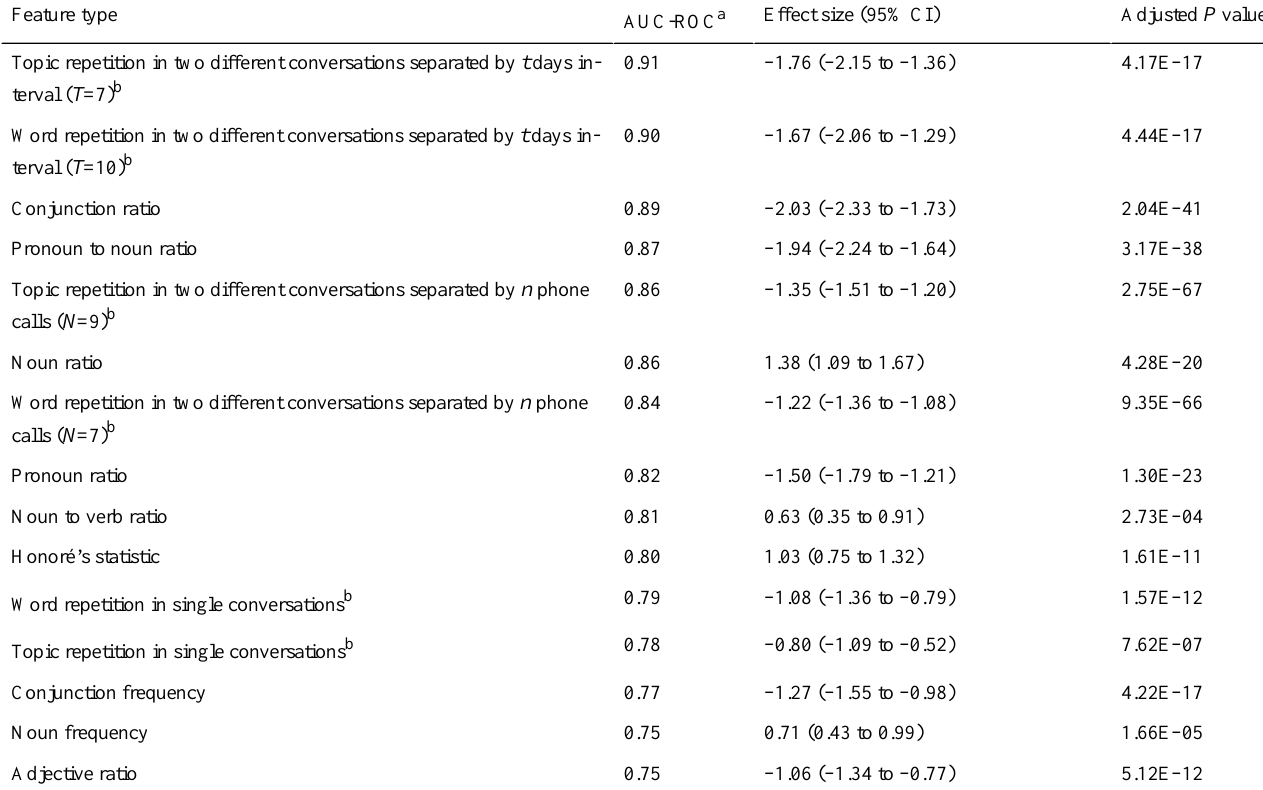
Table 2. Top 15 features of high discriminative power among linguistic features used in previous studies and repetition features. The table contains area under the receiver operating characteristic curve (AUC-ROC) score, effect size (Cohen d) with 95% CI, and P value of 2-sided t test with Bonferroni multiple testing